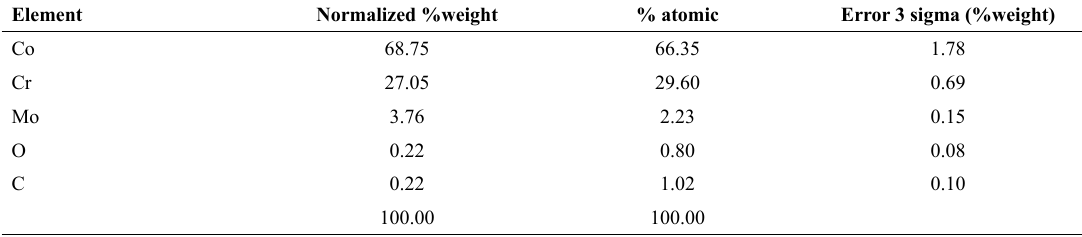
Table 2. Semi quantitative EDS of the Co-Cr-Mo chemical composition analysis.